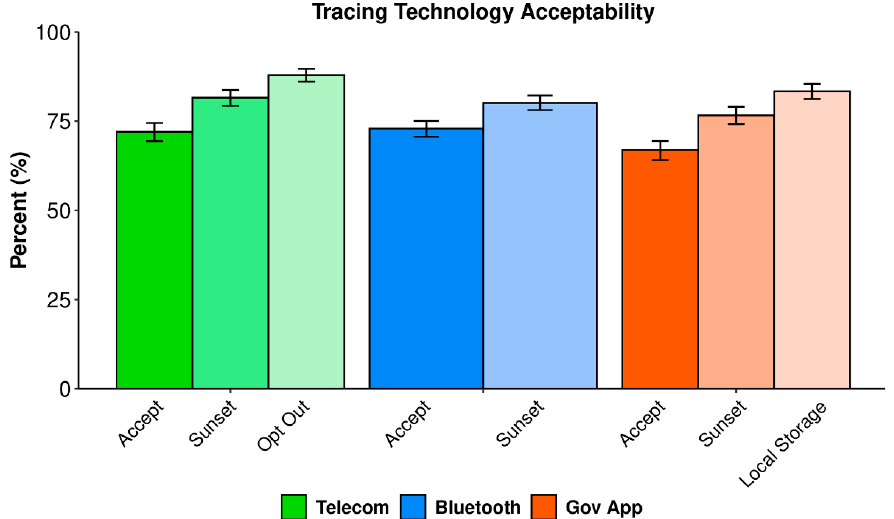
Figure 4. The acceptability and the conditional acceptability of each hypothetical tracing technology. Error bars are 95% Bayesian credible intervals. Highest density intervals within each technology do not